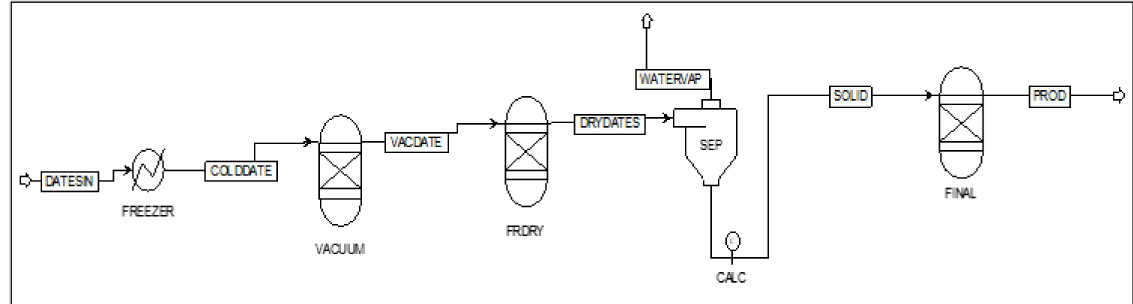
Figure 2. Freeze-drying process flow diagram.